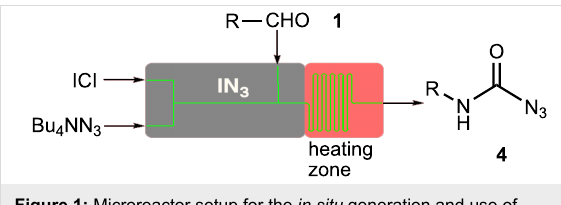
Figure 1: Microreactor setup for the in situ generation and use of iodine azide (IN 3 ).